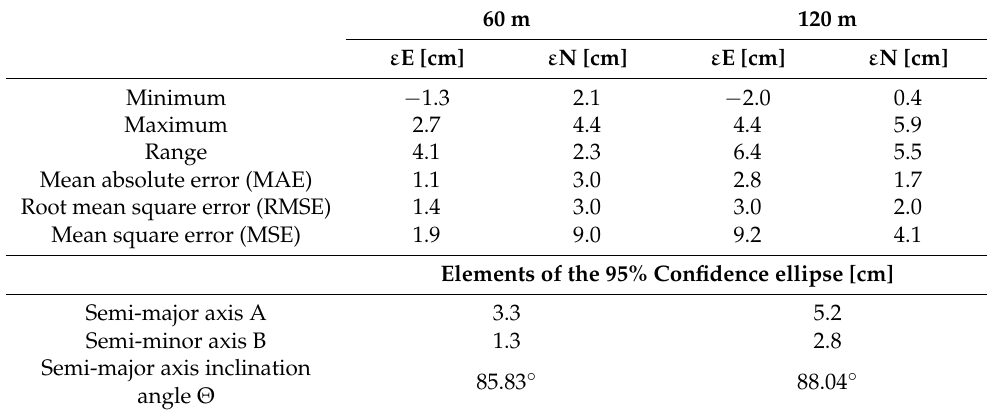
Table 6. UAS DJI Phantom 4 RTK—achieved data quality without the use of GCP (RTK).